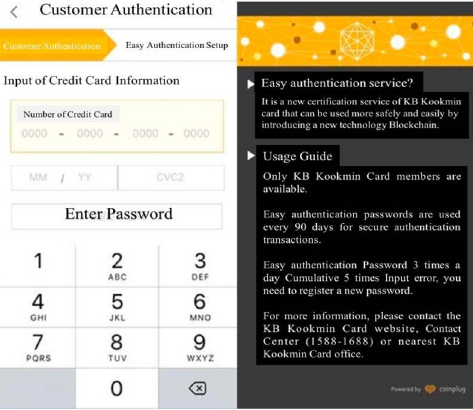
Figure 2. Blockchain-based easy authentication service of the KB Kookmin